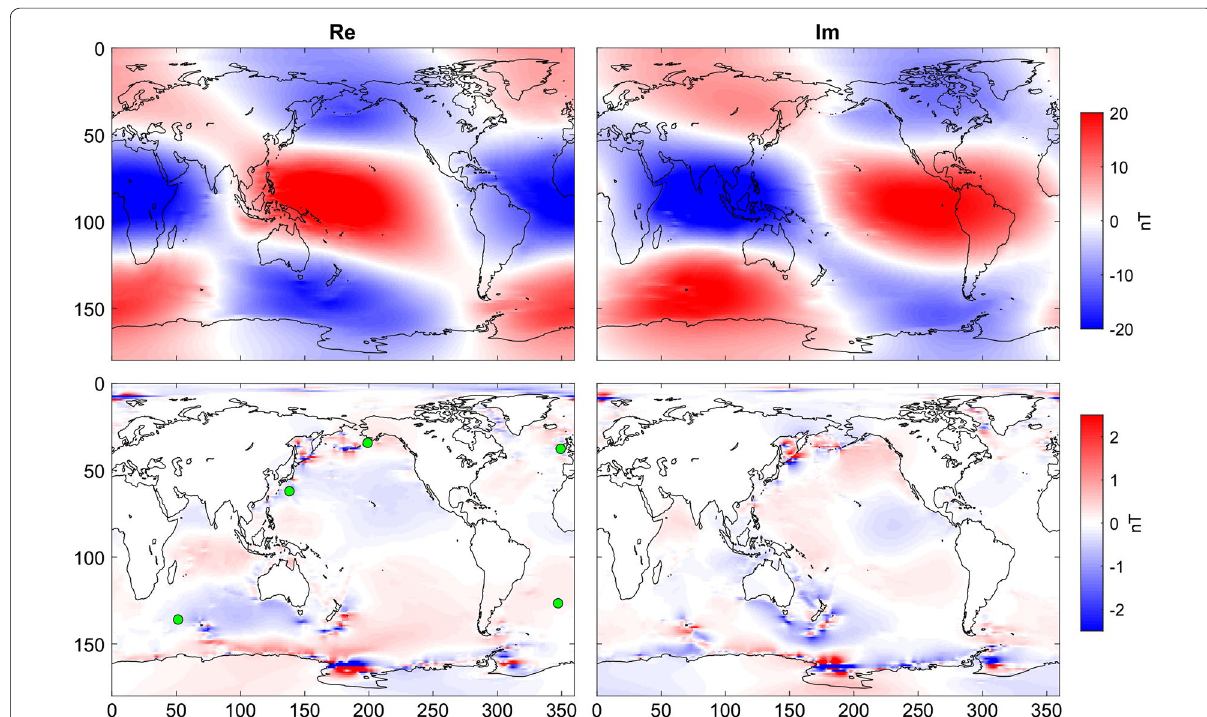
Fig. 11 Modeled X component at a period of 24 h at the sea level. Top and bottom are the Sq and tidal field, respectively. Left and right are the real and imaginary parts, respectively. Green circles denote from left to right CZT (Crozet Archipelago), T12-2 (Philippine Sea), SHU (Alaska), VAL (Ireland), and TDC (Tristan da Cunha). Note the different scales for top and bottom plots